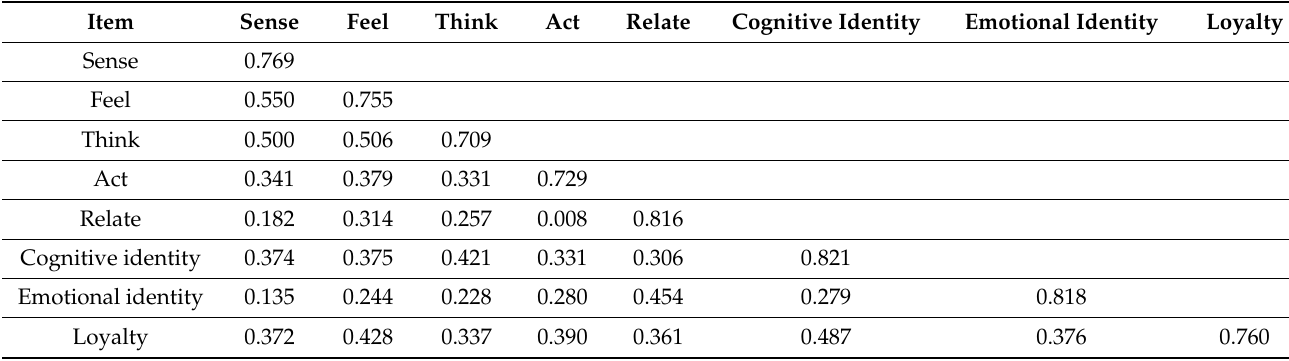
Table 3. Validity